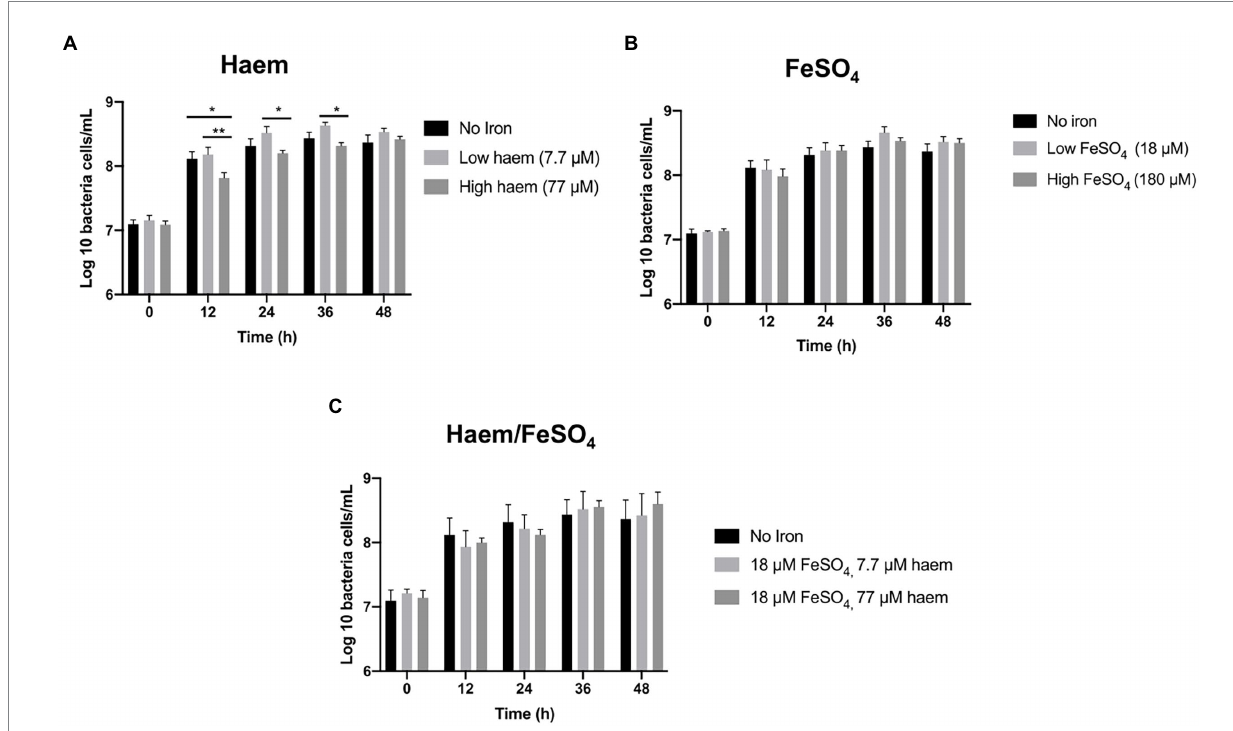
FIGURE 3 Effect of iron regime on gut microbiota in vitro growth in mGMM. Total bacterial counts in single-stage anaerobic batch culture fermenters were analyzed by flow cytometry-fluorescence in situ hybridization (Flow-FISH) to determine the effects of different sources and concentrations of iron in mGMM. (A) Effect of 7.7 and 77 μ M haem on growth. (B) Effect of 18 and 180 μ M FeSO 4 on growth. (C) Effect of combining haem (7.7 and 77 μ M) and 18 μ M FeSO 4 . Error bars show SEM. Batch cultures were ran in triplicate inoculated with faecal samples from 3 different healthy donors ( n = 3). Duplicates were performed for each condition in every case. Significant differences among treatments at the same time point are denotated with asterisks: * p < 0.05; ** p <